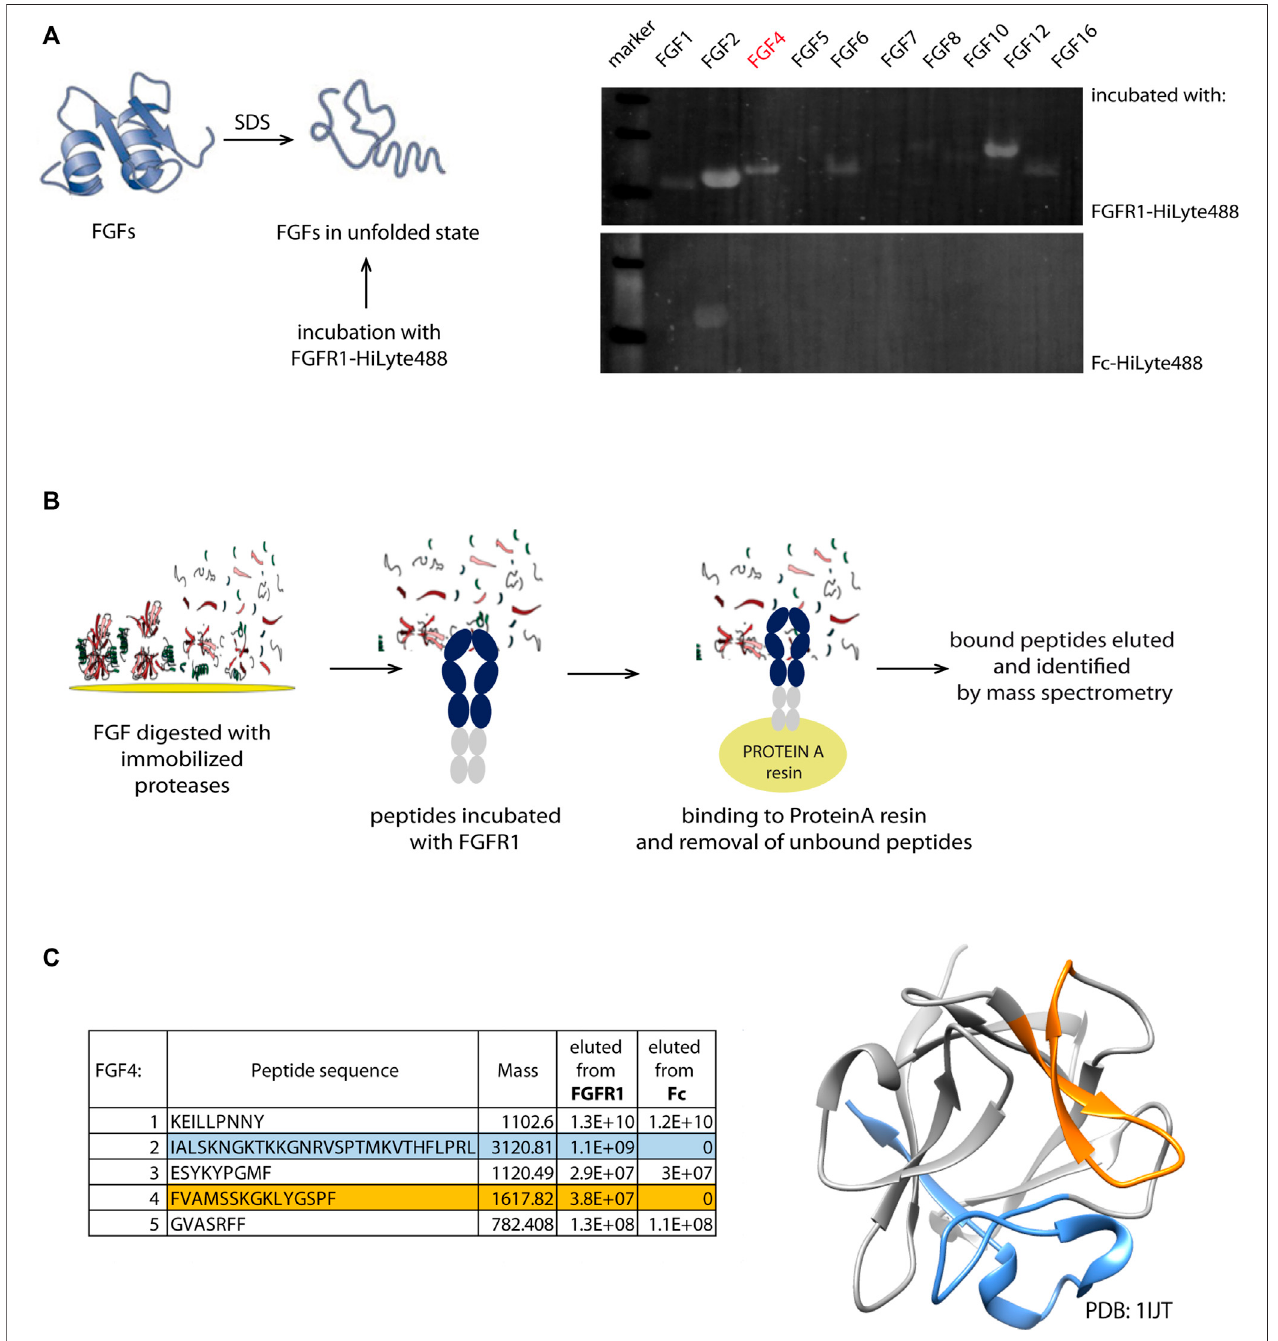
FIGURE 1 | Identi fi cation scheme of new linear FGFR1-binders. (A) Members from FGF family were denatured and immobilized on the PVDF membrane. After incubation with fl uorescently labeled recombinant FGFR1-Fc and Fc domain, the intensity of fl uorescence signal was measured. (B) Schematic work fl ow of pull-down and mass spectrometry based identi fi cation of new FGFR1 binders from the FGF4 sequence. (C) Sequences of new binders (present in the eluate from immobilized FGFR1-Fc, but not Fc) identi fi ed by MS analysis marked in blue and orange in the table and on the FGF4 structure (PDB: 1IJT).